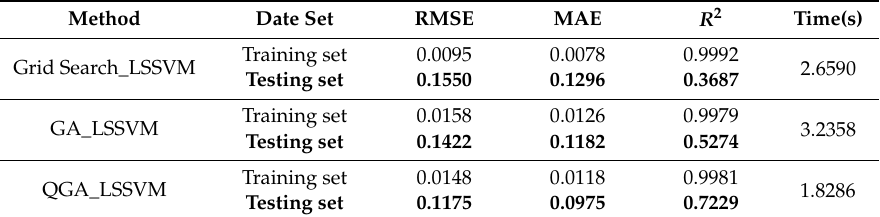
Table 8. The forecasting evaluation indexes of the vibration signal.